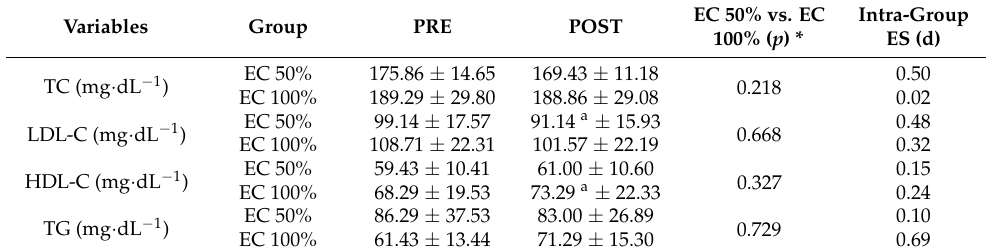
Table 6. Results of Lipid